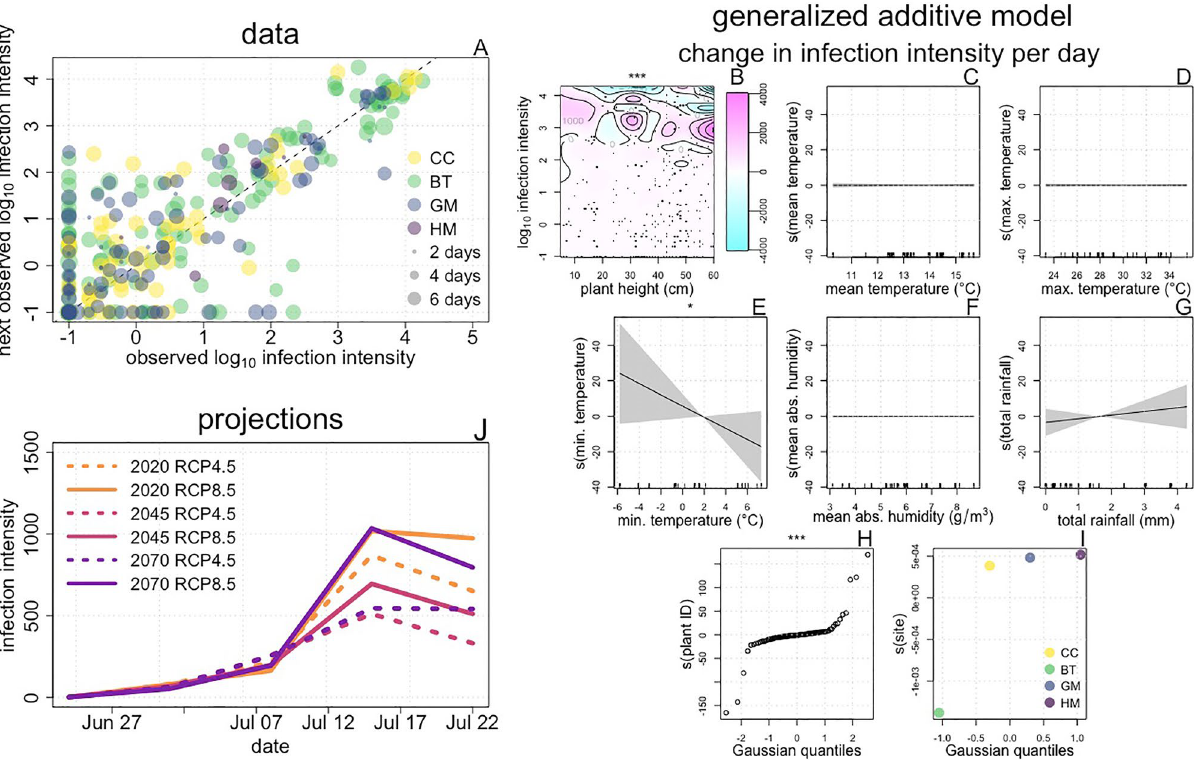
Figure 3. The effects of climate change on the progression of M. lini infection intensity. Data: Across 90 diseased focal plants, we made 313 observations of infection intensity (Panel A ). Both increases and decreases in infection intensity are expected, as both the proliferation of infection and the deterioration of infected tissue may occur. Panel ( A ) shows log 10 transformed observed data, with each point representing one observation. Point color indicates study site, and point size represents the elapsed time between observations. The dashed line indicates y = x to illustrate where increases and decreases in infection intensity occur. Generalized additive model: We fit a GAM of change in infection intensity per day, using an identity link function. Predictors included smooth terms for environmental conditions, a full tensor smooth product (which captures both individual and joint effects of predictors) of log 10 infection intensity and plant height, and random effect smooths for plant identity and site. We expect height and infection intensity to have a joint effect for two reasons. First, height can partially constrain infection intensity by limiting the amount of tissue that can be infected. Second, quantitative resistance, which could slow the spread of infection within a plant, could be correlated with plant size, as leaf age influences pustule development 20 . Panel ( B ) shows the fitted tensor product, with colors and contours indicating the tensor value (analogous to smooth value) for different combinations of plant height and log 10 infection intensity. Points indicate observed data. Panels ( C – I ) show the fitted smooth terms, with axes, lines, and shading as in Fig. 2B–G. Panels ( H ) and ( I ) show fitted random effects, with points and axes as in Fig. 2H–I. Symbols above plots show the significance of smooth terms, with *** indicating p < 0.001, ** indicating p < 0.01, and * indicating p < 0.05. Projections: We simulated 100 trajectories of infection intensity for a lightly infected plant (infection intensity 1) of approximately average height (25 cm) at each site for six future weather data sets using the fitted GAM. The means of these trajectories, simulated for the GM site, are shown in panel ( J ). These results qualitatively match those simulated for other sites (Supplementary Fig.